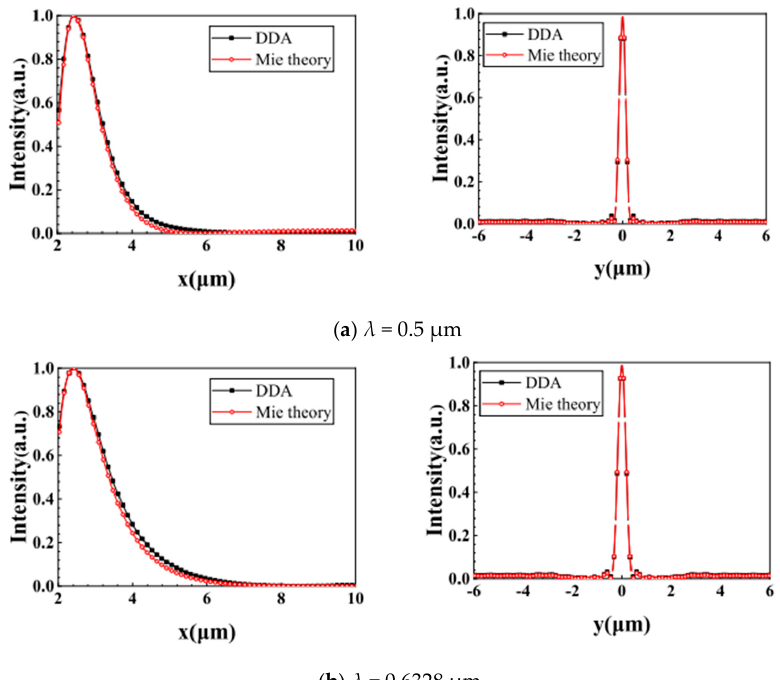
Figure 4. Comparison of theoretical calculation results between DDSCAT and Mie. ( a , b ) describe the comparison results of the two methods when the wavelength is 0.5 μ m and 0.6328 μ m, respectively. The first picture in each row is the intensity distribution along the x-axis through the focal point of the photonic jet. The second picture is also the intensity distribution but along the y-axis through the focal point.